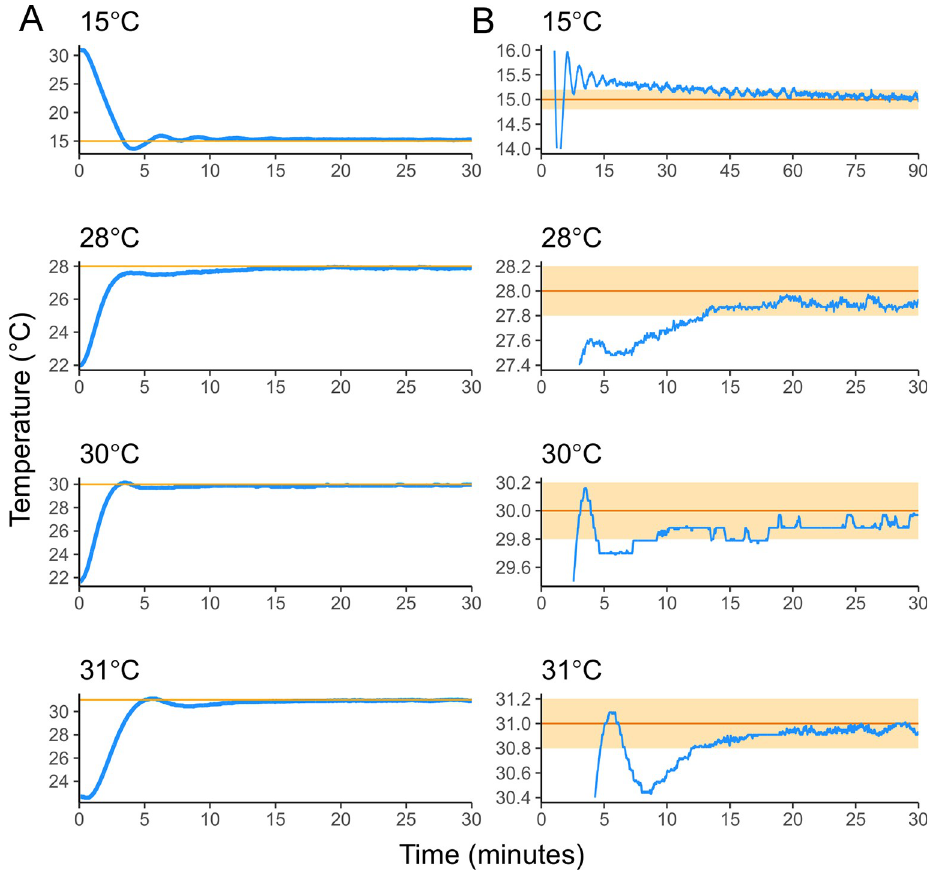
Fig 2. Temperature curves showing how quickly the device achieves set point temperatures. (A) The device achieved stability within 1˚C of all set point temperatures (orange lines) within five minutes, including the transition to 15˚C from 32˚C. (B) Device temperature will continue to converge to the set point (orange line) over time, achieving stability +/- 0.2˚C (orange shading) within 15 minutes and +/- 0.1˚C within 30 minutes for the warmer set points. Cooling to 15˚C took longer, and was achieved to +/- 0.2˚C in about an